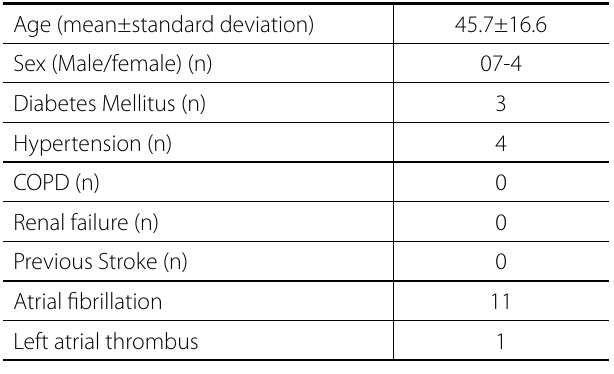
Table 1 . Baseline and datas.